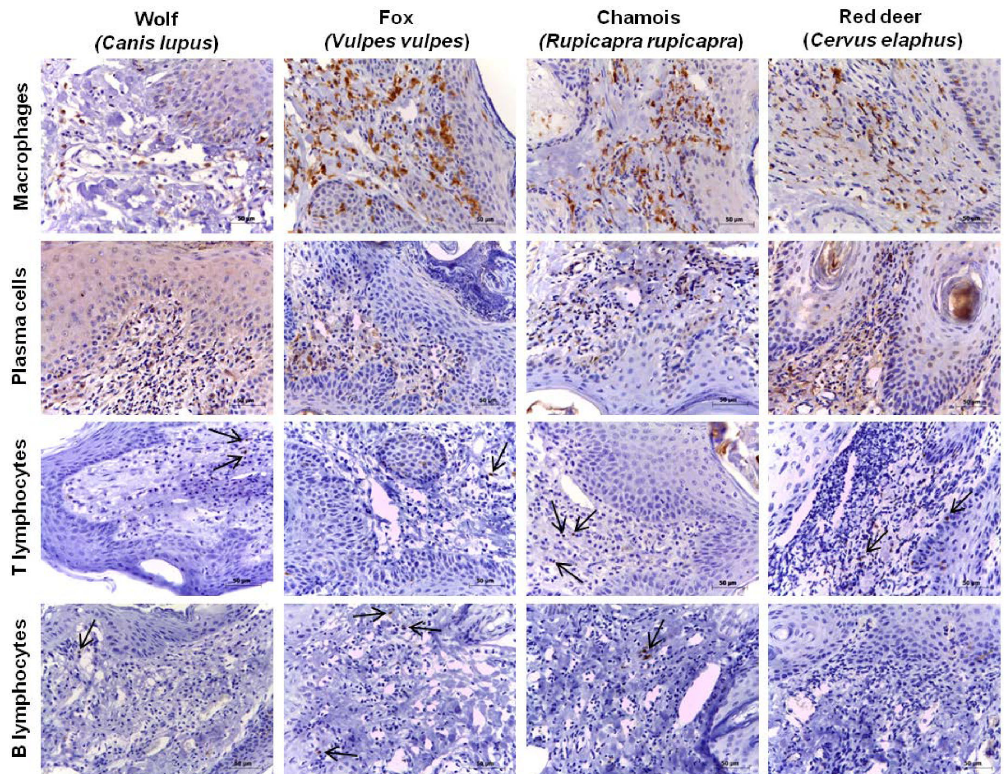
Figure 2. Comparative immunohistochemistry of cellular response in the dermis of wolves, foxes, chamois and red deer naturally infested with Sarcoptes scabiei . Skin biopsies were stained with primary antibodies against the indicated markers and the avidin-biotin complex kit. Macrophages were the predominant type of inflammatory cell in all species (top row). Plasma cells were present in all species, but less abundant than macrophages (second row). T lymphocytes (third row) and B lymphocytes (bottom row) were scarce in all species. Arrows indicate examples of stained cells when they are scarce (even with no B lymphocytes in red deer). Tissue sections in each column came from the same animal, and the results shown are representative of all five animals of each species. Bars = 50 microns.